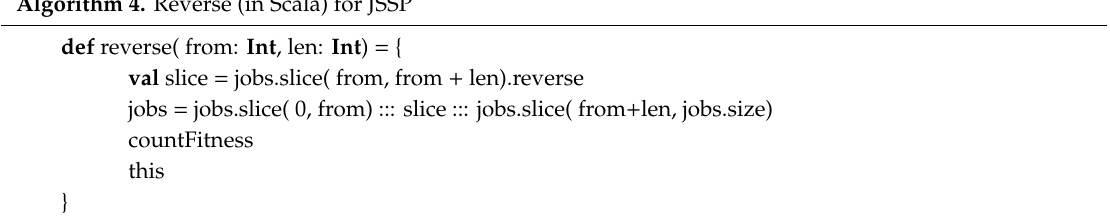
Algorithm 4. Reverse (in Scala) for